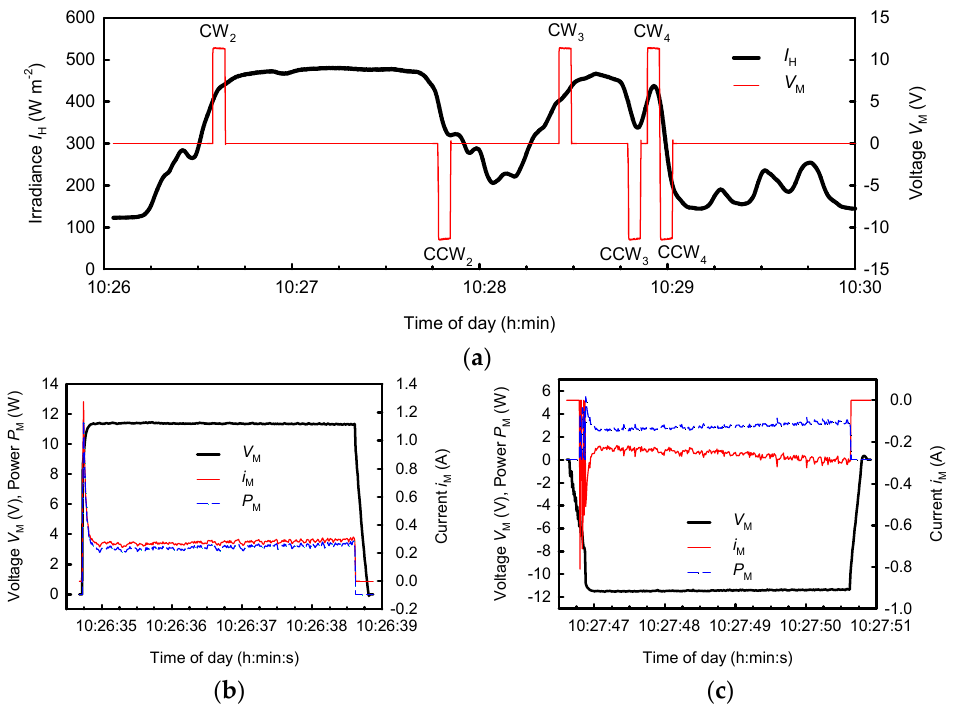
Figure 9. PV blind operations in response to irradiance I H on 27 November 2017: ( a ) motor voltage V M represents the blind operations at threshold I H = 400 W m − 2 ; ( b ) motor current i M , voltage V M , and power P M during CW 2 ; ( c ) CCW 2 . Table 2. Threshold irradiance I H , rotating duration t of the direct current (DC) motor, and energy consumption e during the clockwise (CW) and counter-clockwise (CCW) rotations at each R 0 value of the PV blind control circuit.